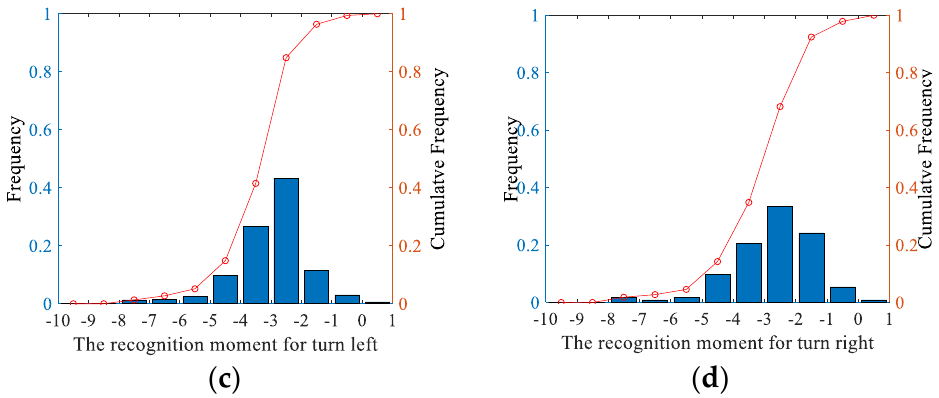
Figure 18. Statistical distribution for the correct recognition result. ( a , b ) shows the driving behavior recognition time: ( a ) for TL, ( b ) for TR. ( c , d ) are the statistics of the recognition time of the TL and TR maneuvers, respectively, using the proposed hybrid method.